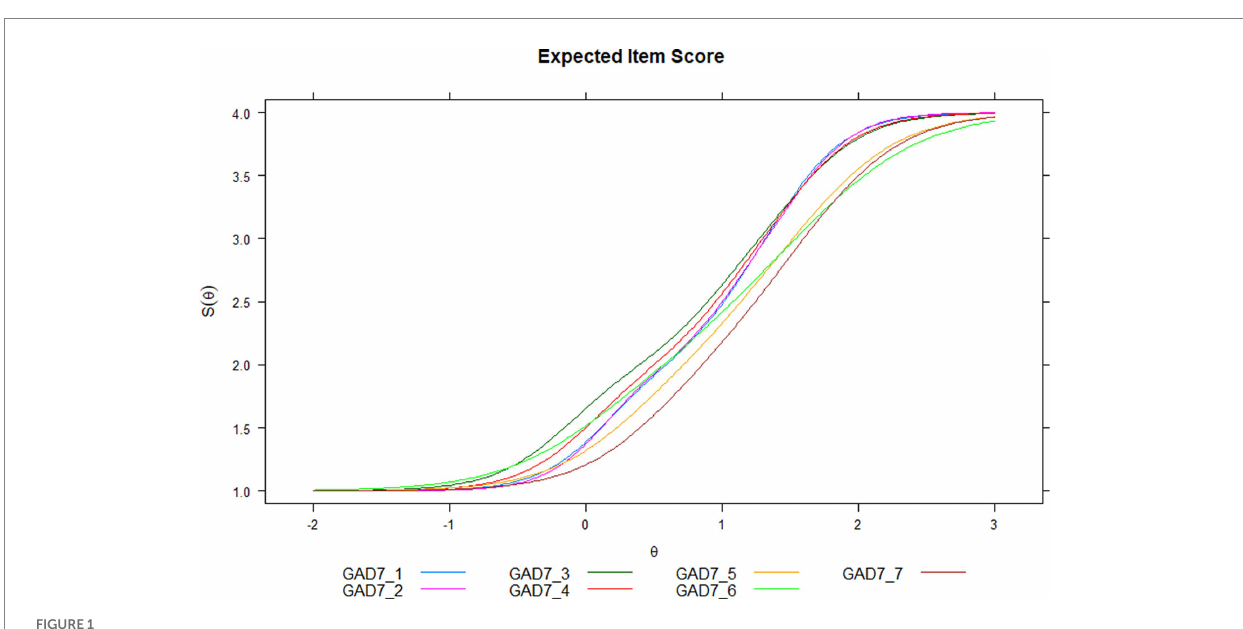
FIGURE 1 Expected item score.